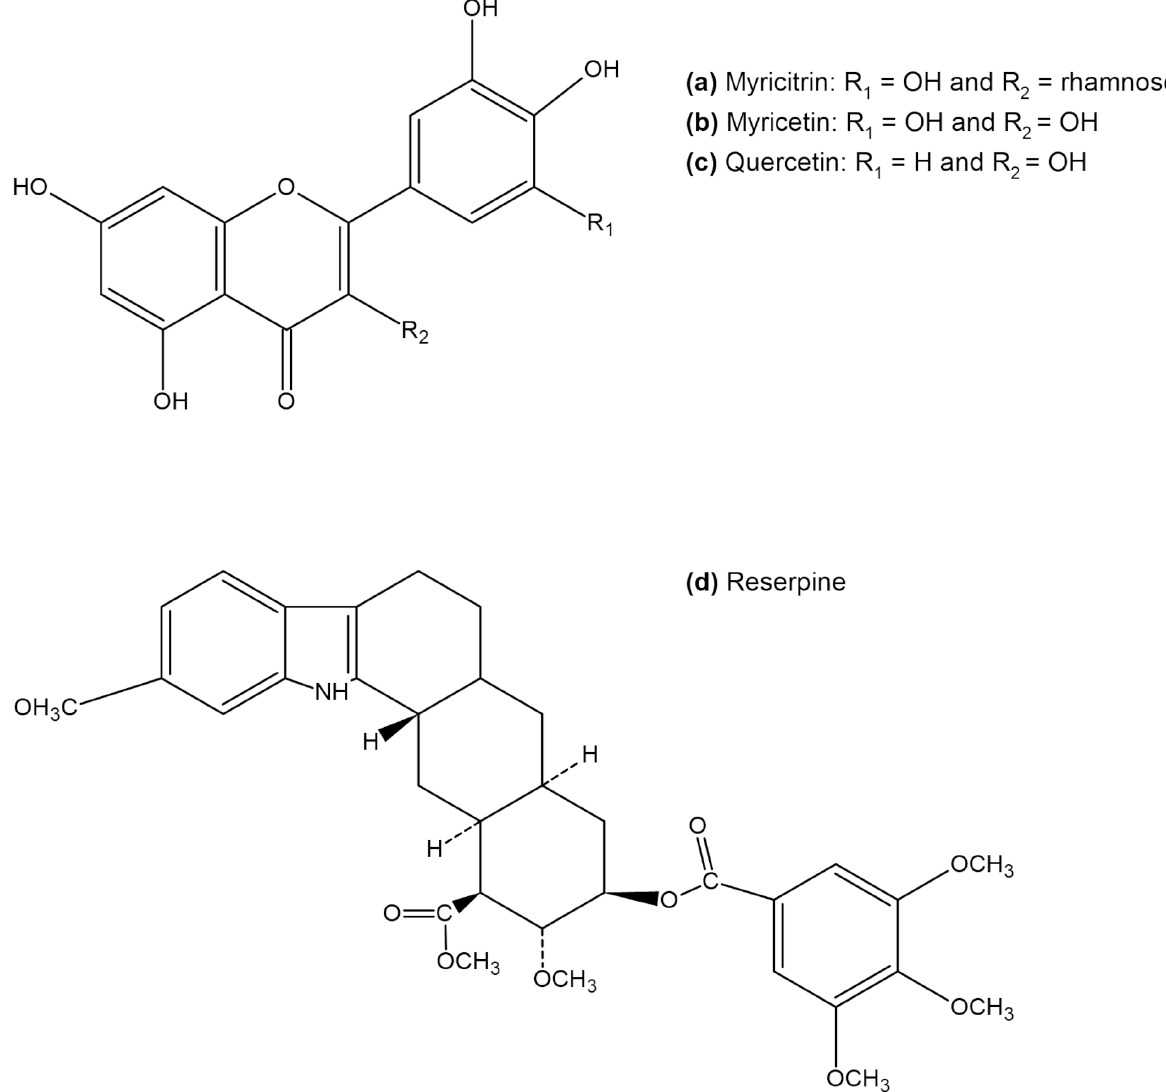
Figure 8. Chemical structure of myricitrin (a), myricetin (b), quercetin (c), and reserpine